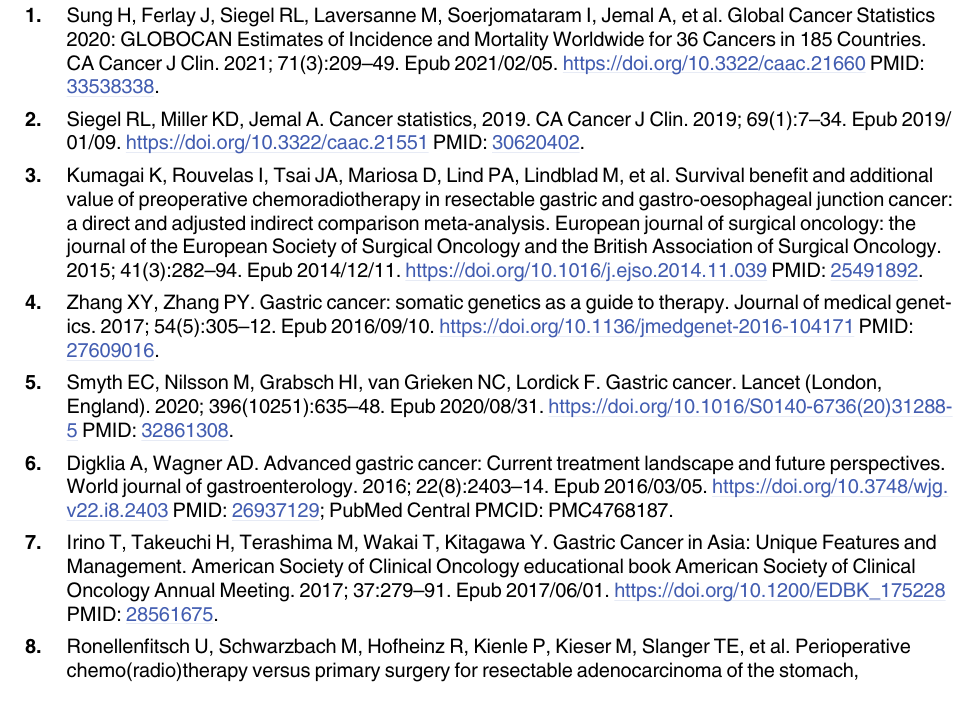
S1 Table. Baseline characteristics of the radiotherapy patients between the training set and the validation